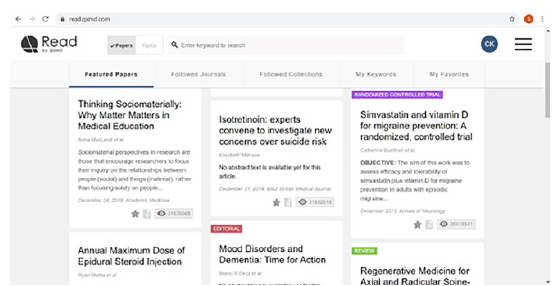
Figure 1 Read by QxMD web